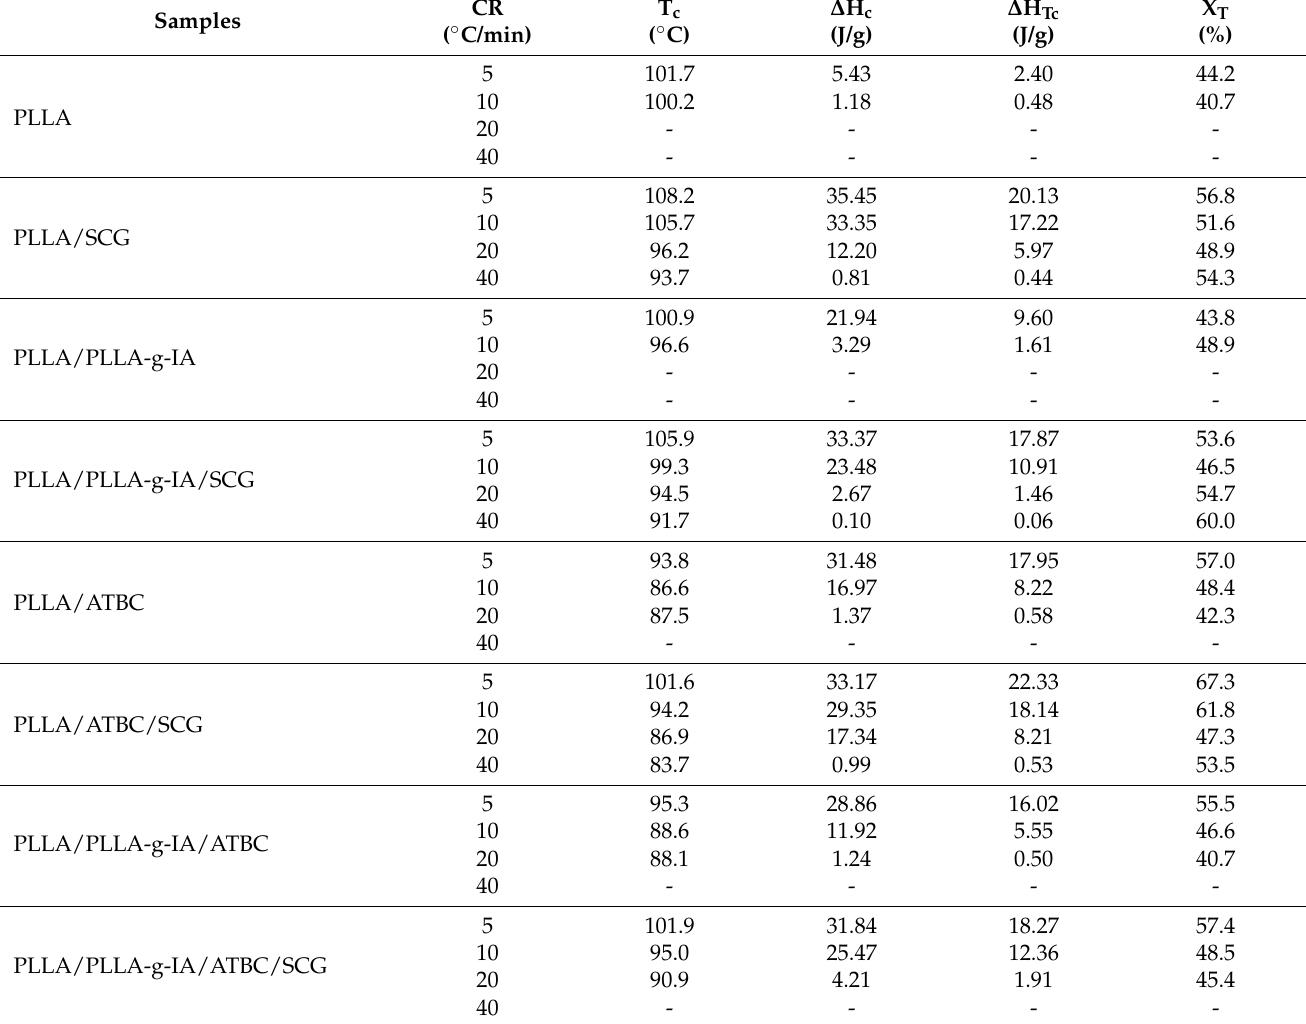
Table 4. The results from the cooling run of DSC